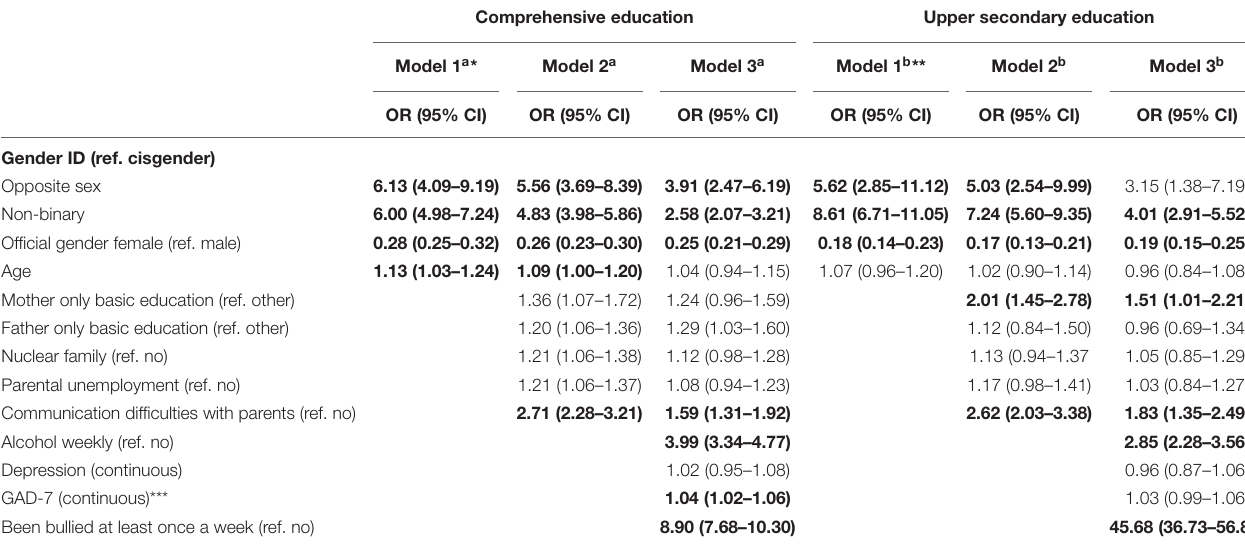
TABLE 4 | Regression analysis for perpetration of